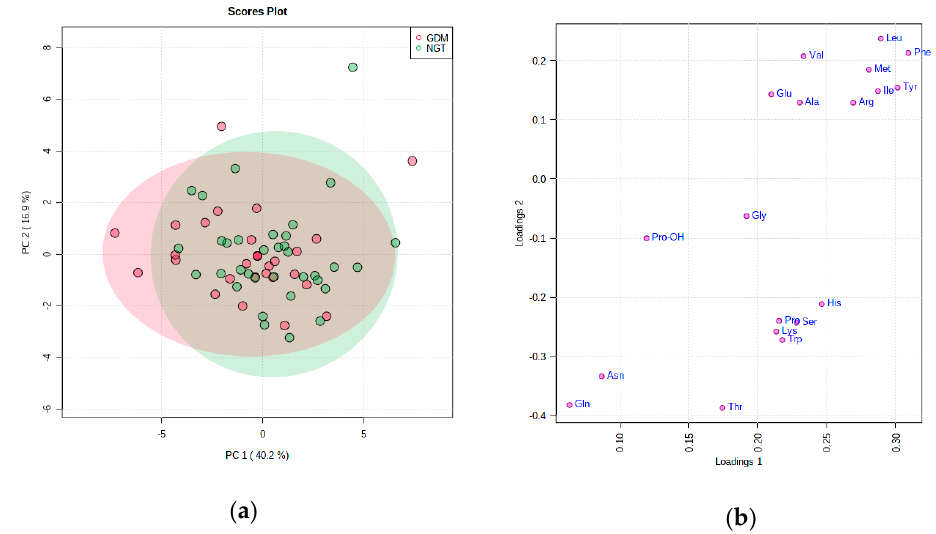
Figure 5. Principal component analysis (PCA) results for amino acids concentrations in pregnant NGT and GDM patients group. ( a ) Scores plot between the PC1 and PC2 for NGT and GDM patients. The explained variances are shown in brackets; ( b ) loadings plot of 19 amino acids for PC1 (Loadings 1) and PC2 (Loadings 2).